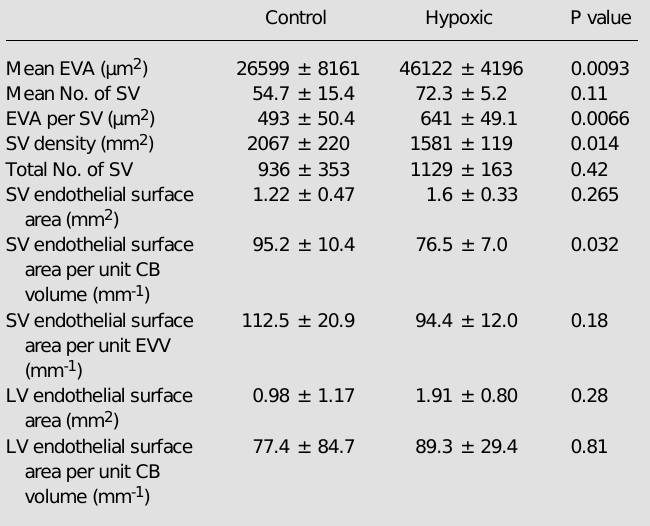
Table 2 - Vascular endothelial surface areas of control and hypoxic rat carotid bodies (CB), mean extravascular area (EVA), number of small vessels, extravascular area per small vessel, small vessel density, and total number of small vessels, all based on a sampling interval of 25 µm. Values are reported as means ± SD for carotid bodies of 5 control and 3 hypoxic rats. P values were determined by Student’s unpaired t -test. EVV, Extravascular volume; LV, large vessel; SV, small